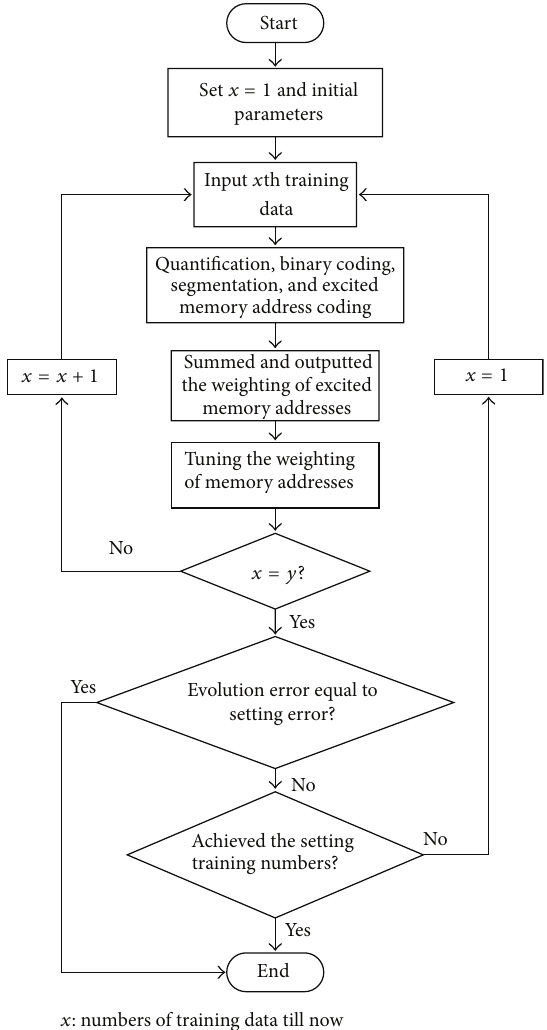
Figure 7: Flowchart of the CMAC training